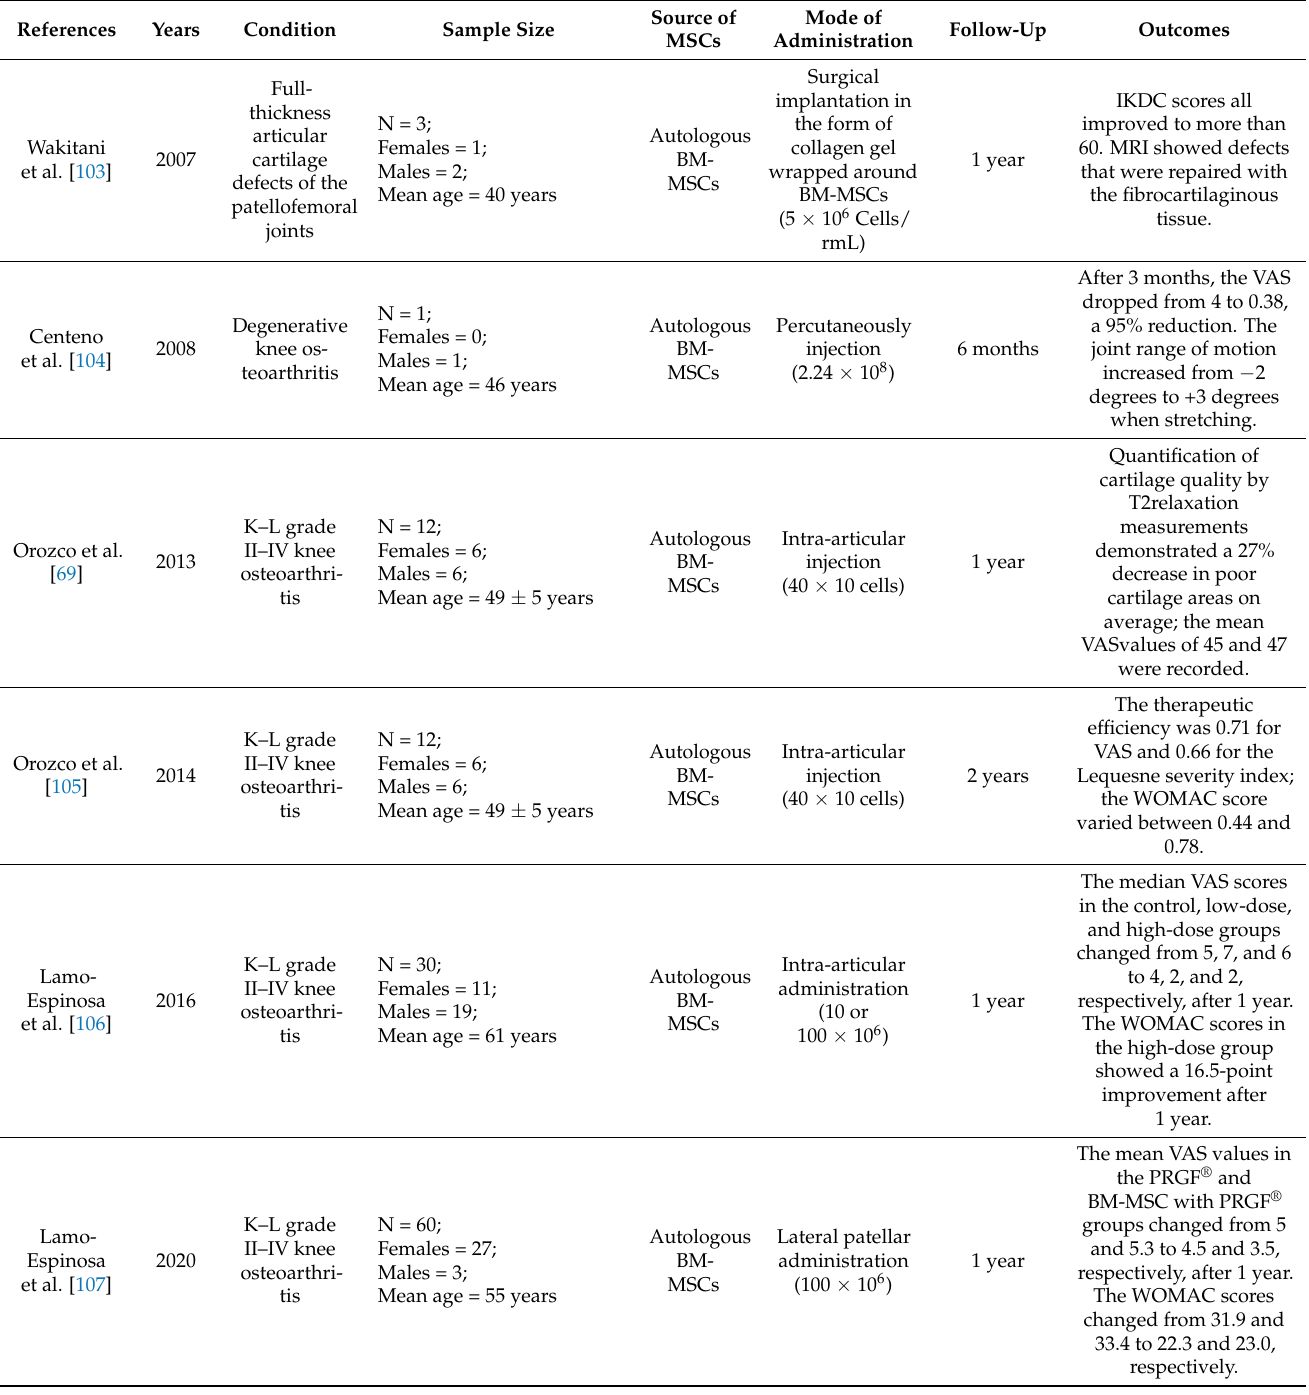
Table 2. Overview of clinical studies applying different sources of MSCs for OA